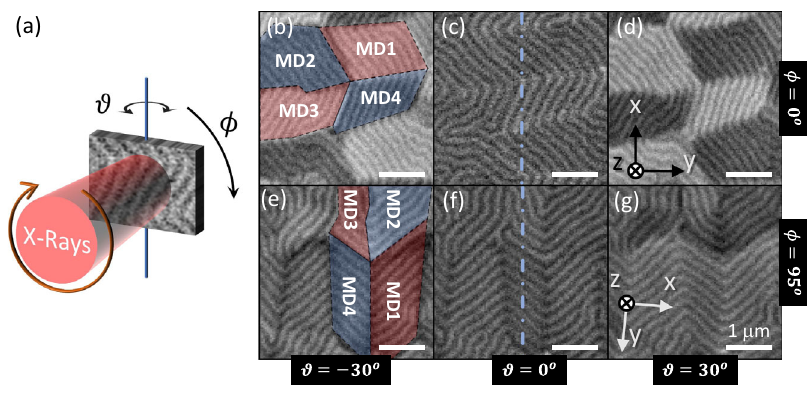
Fig. 2 MTXM images at different angular orientations at Gd M 4,5 edge. a Sketch of X-ray beam/sample geometry at the MISTRAL microscope indicating angles ϑ and ϕ . Tilt series 1 ( ϕ ¼ 0 (cid:3) ): b ) ϑ ¼ (cid:2) 30 (cid:3) ; c ) ϑ ¼ 0 (cid:3) ; d ) ϑ ¼ þ 30 (cid:3) . Tilt series 2 ( ϕ ¼ 95 (cid:3) ): e ) ϑ ¼ (cid:2) 30 (cid:3) ; f ) ϑ ¼ 0 (cid:3) ; g ) ϑ ¼ þ 30 (cid:3) . Dashed line indicates rotation axis for each tilt series. Gray scale in MTXM images indicates magnetic contrast, given by the projection of the magnetic moment along the X-ray beam direction (bright/dark contrast corresponds to local magnetic moment parallel/antiparallel to the X-ray beam). Thus, depending on the angle of incidence, images in Tilt series 1 are sensitive to m y and m z , whereas images in Tilt series 2 are sensitive to m z and approximately m x . Labels and blue/red shades indicate Magnetic quasi-Domains (MD) with different average in-plane by the average angle of oscillation of the stripe pattern at MD1. Þ , so that the As sketched in the inset of Fig. 3(d), γ ¼ asin ð m z